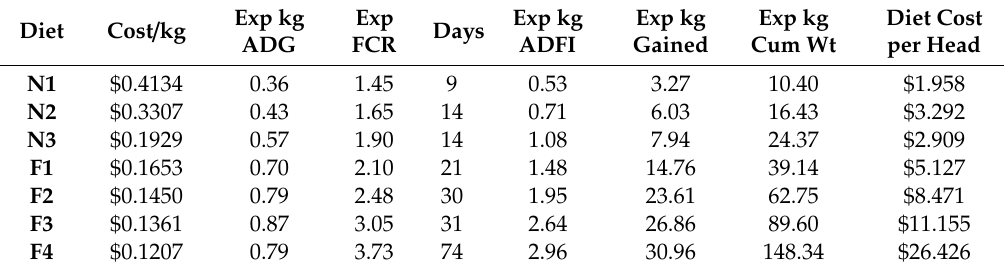
Table 3. Costs of diet and performance assumptions used to calculate feed costs per pig. Diets are designated by their phase and sequence (numeral) fed diet in the phase. N1 is the first nursery diet and